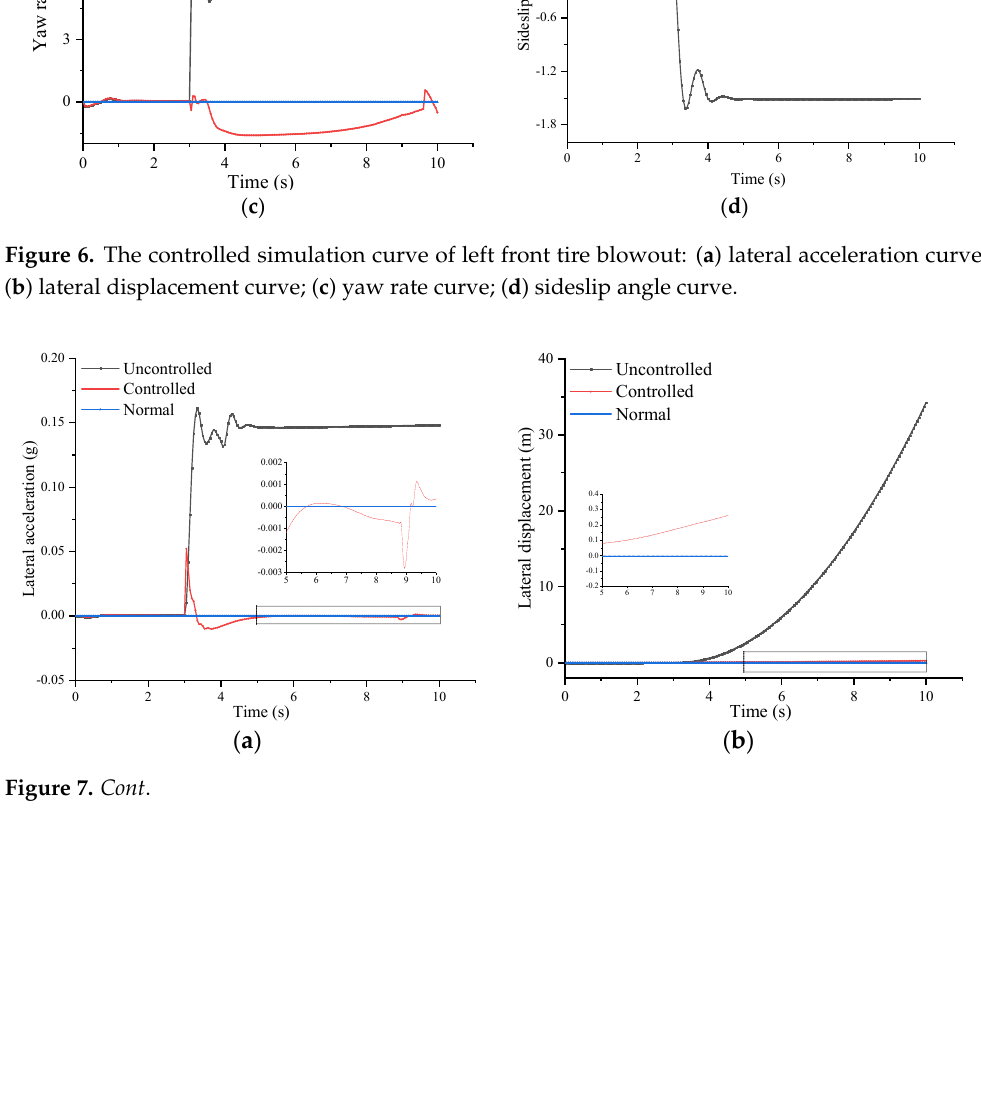
Figure 6. The controlled simulation curve of left front tire blowout: ( a ) lateral acceleration curve; ( b ) lateral displacement curve; ( c ) yaw rate curve; ( d ) sideslip angle curve.